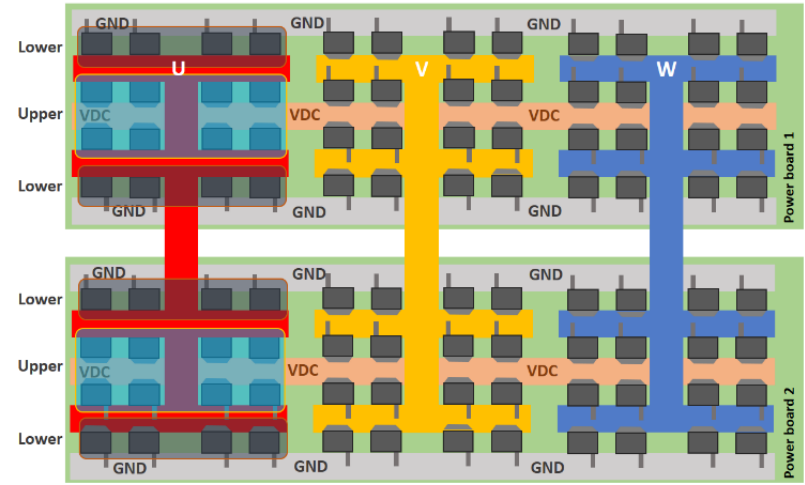
Figure 4. Three-phase Simrod inverter board.